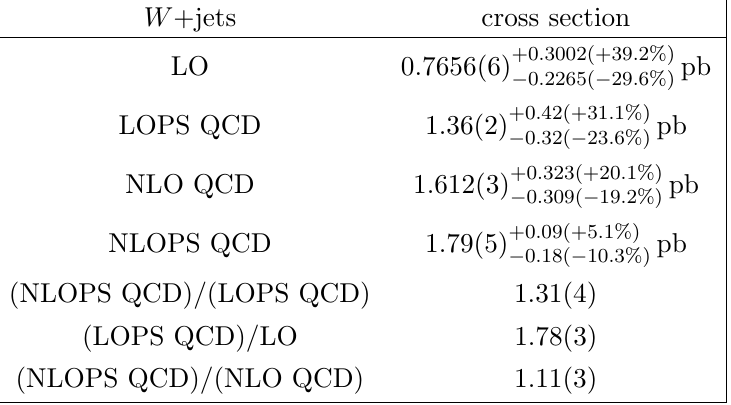
Table 4 . Total cross sections and their uncertainty from scale dependence in various QCD approx- imations for the signature (2.1) from W +jets within the (cid:12)ducial region de(cid:12)ned in section 3.1. The ratios are computed for the central values of the corresponding